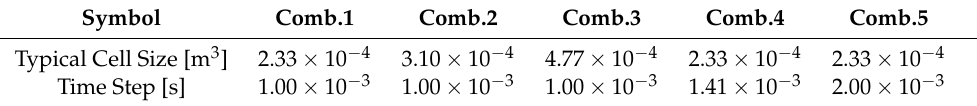
Figure 12. Time series of the free decay test of pitch. Table 4. Combinations of typical cell size and time steps used in the free decay test of heave.